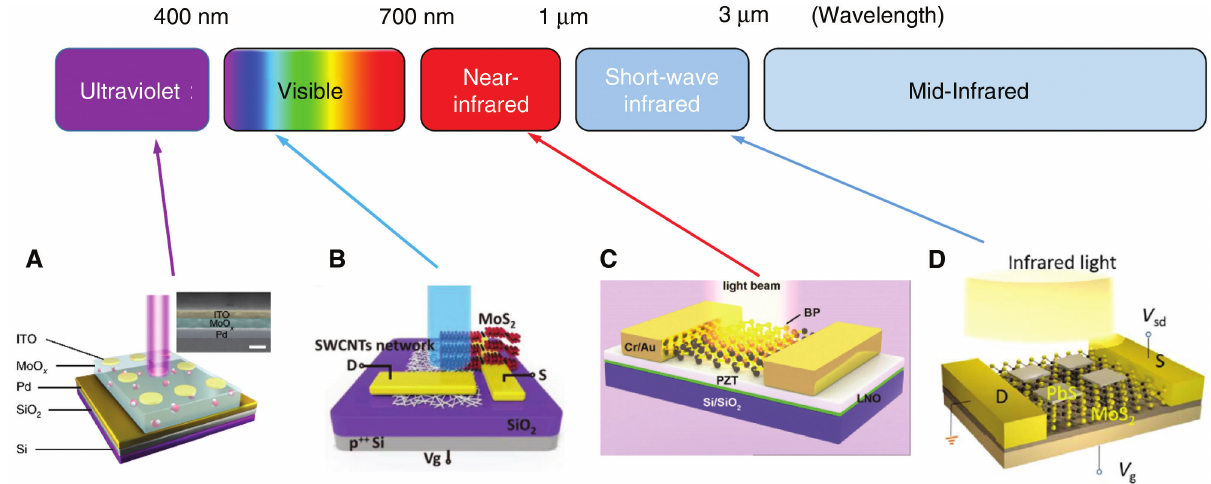
Figure 1: Electromagnetic spectrum (top portion) and photonic memristors (bottom portion) that utilize different 2DMs and device configurations covering spectral from Ultraviolet to